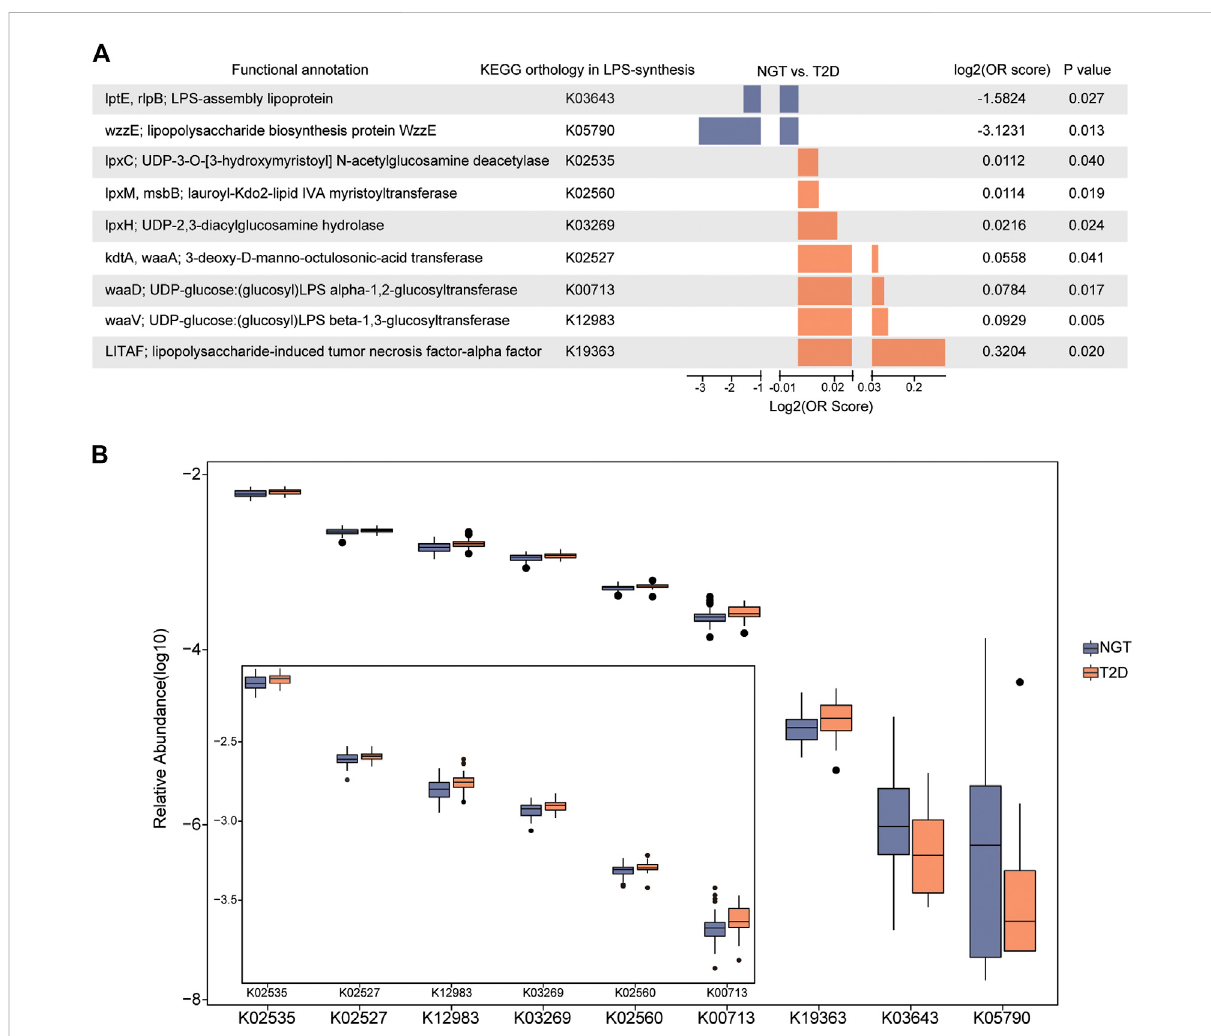
FIGURE 3 Disparate abundance of gut microbial KOs associated with LPS biosynthesis between individuals with NGT and patients with T2D. (A) Enrichment of the LPS-biosynthesis-related KOs with distinct abundance between individuals with NGT and patients with T2D. Log2 (OR score) < 0 (enriched in NGT, blue); Log2 (OR score) > 0 (enriched in T2D, orange), p < 0.05. (B) Box plots illustrating the relative abundance of KOs varied signi fi cantly between the NGT and T2D groups. Horizontal lines within the box plots represent median values, upper and lower ranges of the box represent 75% and 25% quartiles, respectively, and circles represent outliers. T2D, type 2 diabetes; NGT, normal glucose